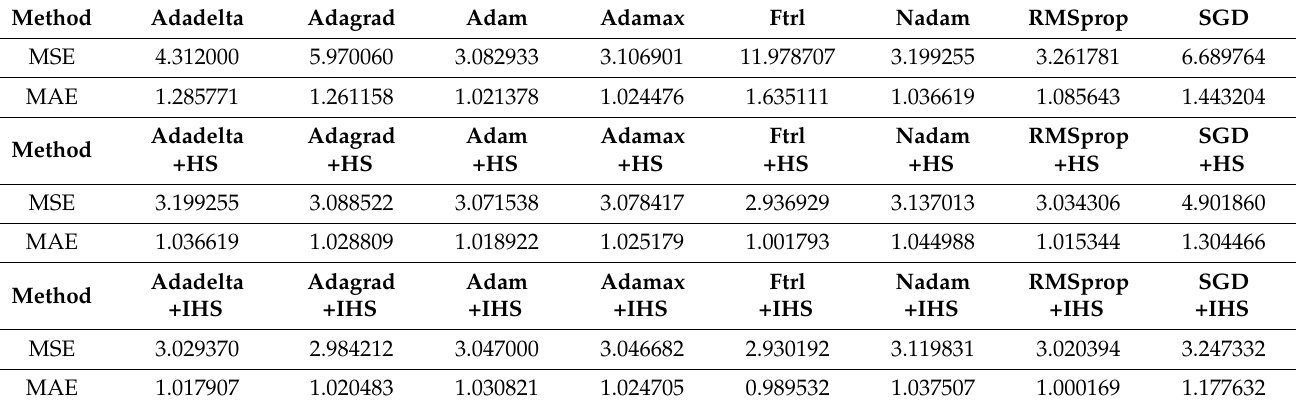
Table 5. Results of inflow